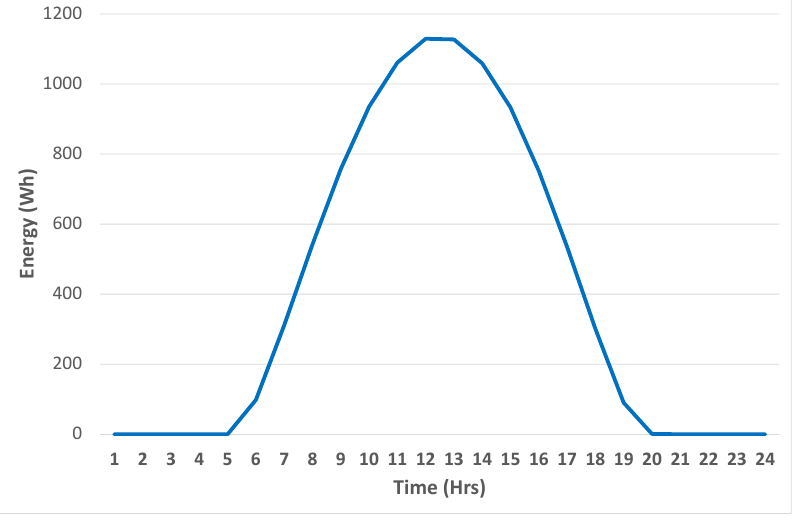
Figure 13. Solar radiation